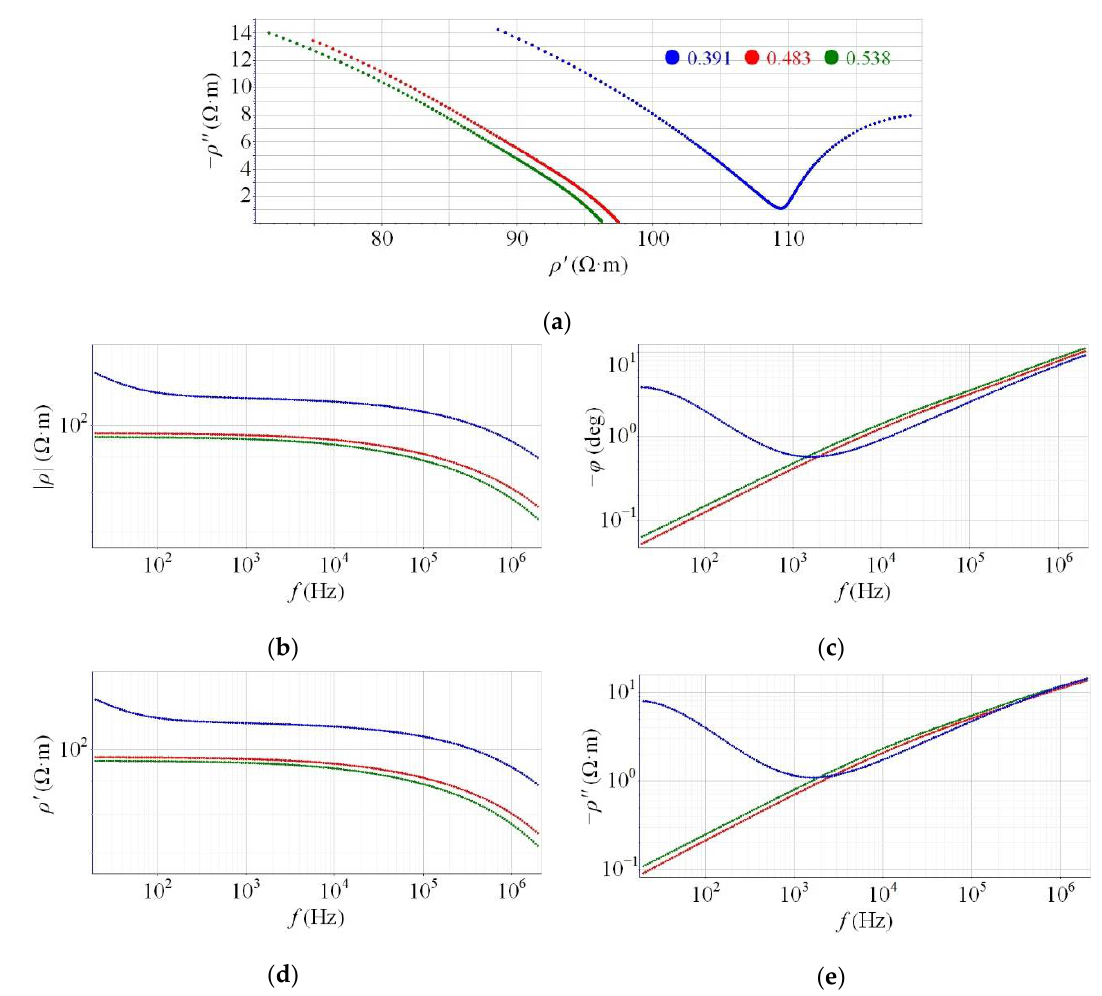
Figure A4. Impact of changes in dry density on complex resistivity of substrate. ( a ) Nyquist plots; ( b ) magnitude spectra; ( c ) phase spectra; ( d ) in-phase conductivity spectra; ( e ) quadrature conductivity spectra. For the spectra marked by different colors, the variable dry densities are provided in ( a ), while the related volumetric water contents (Table 3) are considered to be nearly equal. The frequency range is from 20 Hz to 2 MHz.